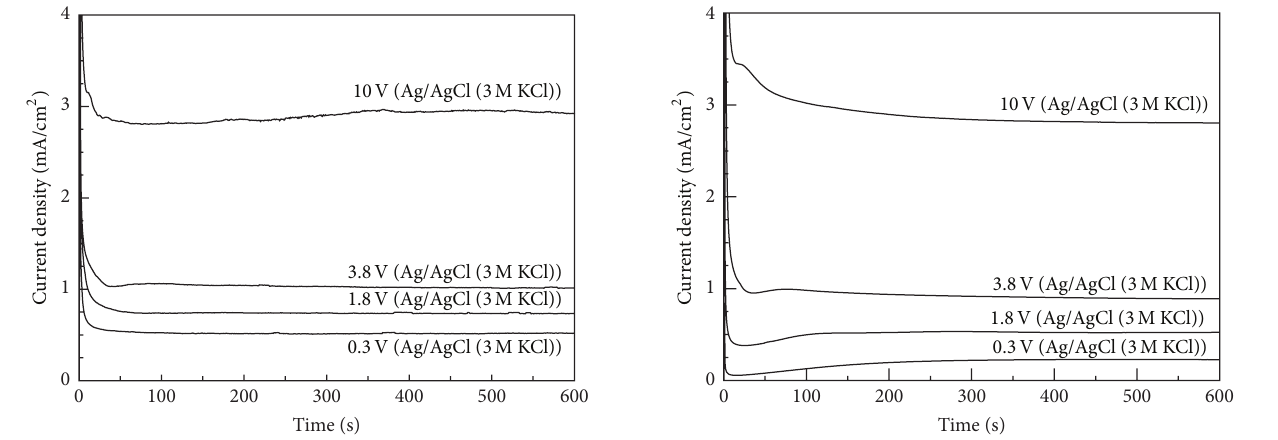
Figure 5: Current density-time behaviour during potentiostatic anodising in 0.4 M sulphuric acid on EN AW-7075 T73 using the conventional technique to form circular areas 10mm in